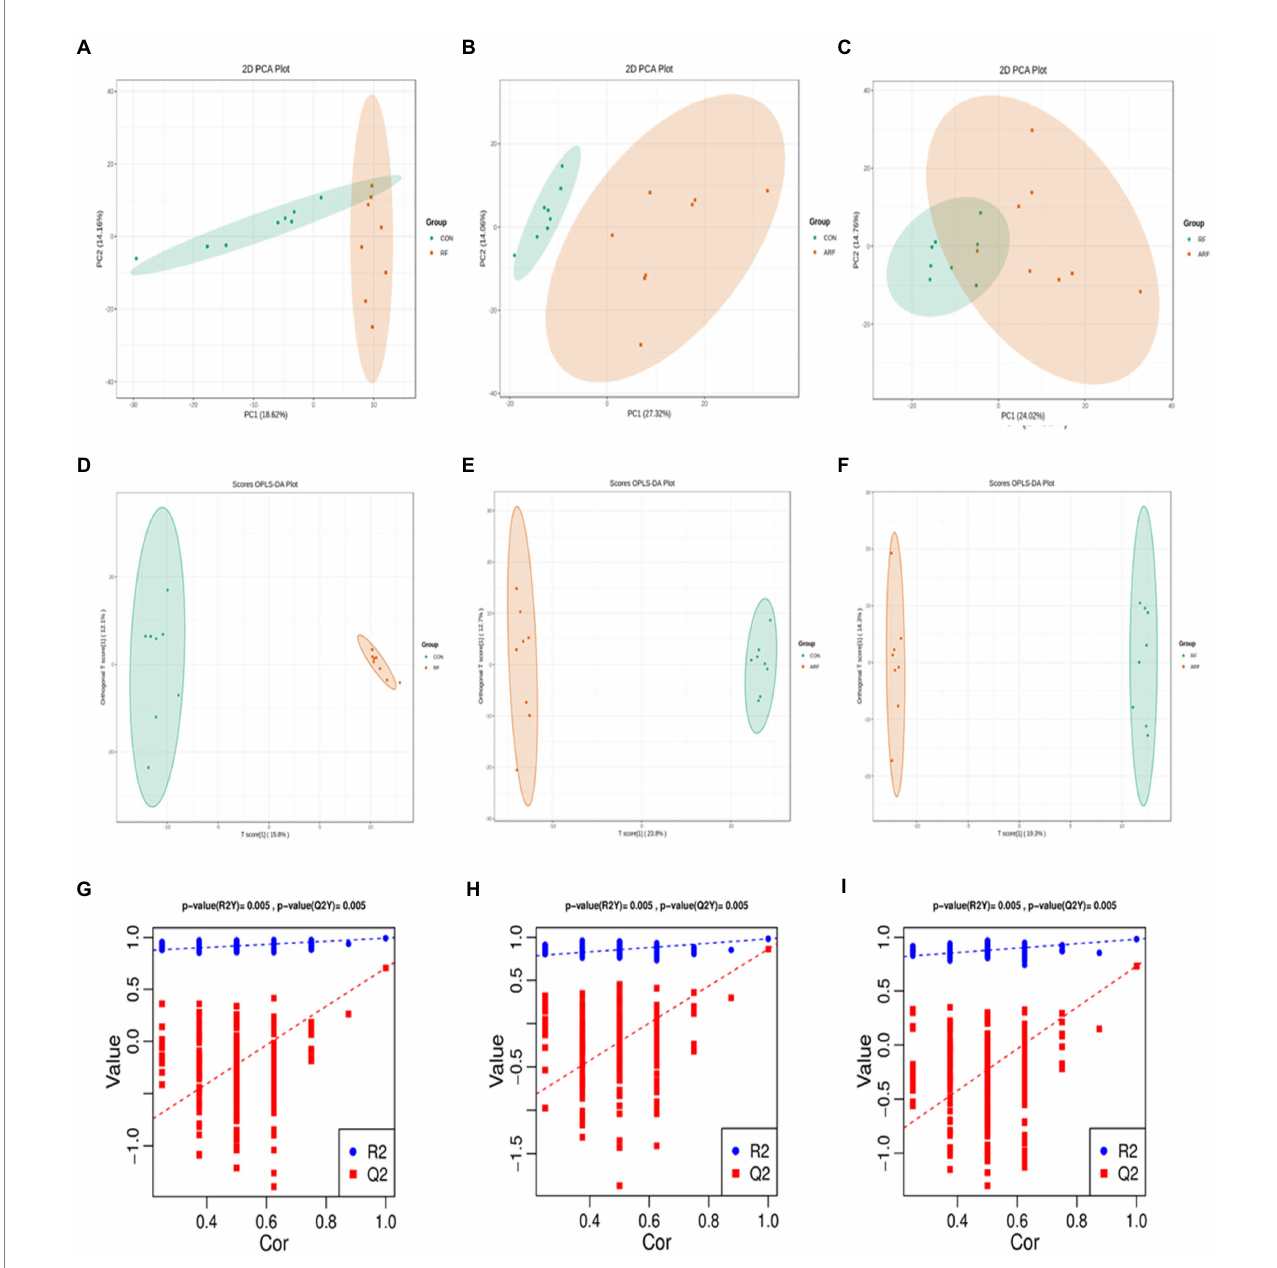
FIGURE 5 Metabolomics of PCA analysis, CON group (green) and RF group (red) (A) , OPLS-DA score chart, CON group (green) and ARF group (red) (B) , OPLS-DA score chart, RF group (green) and ARF group (red) (C) . OPLS-DA score chart, CON group (green) and RF group (red) (D) , OPLS-DA score chart, CON group (green) and ARF group (red) (E) , OPLS-DA score chart, RF group (green) and ARF group (red) (F) . Permutation test of OPLS-DA (G–I)